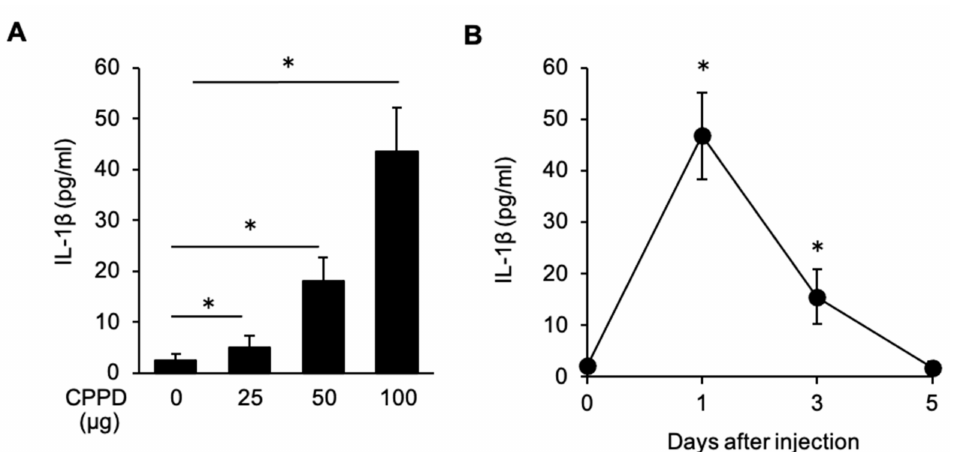
Figure 4. CPPD injection induces IL-1 β production in vivo. ( A , B ) Serum IL-1 β production in WT mice 1 day after CPPD administration at the indicated concentration. ( B ) Kinetics of serum IL- 1 β production after CPPD administration. Data represent the mean ± s.d. of three independent experiments. * p <